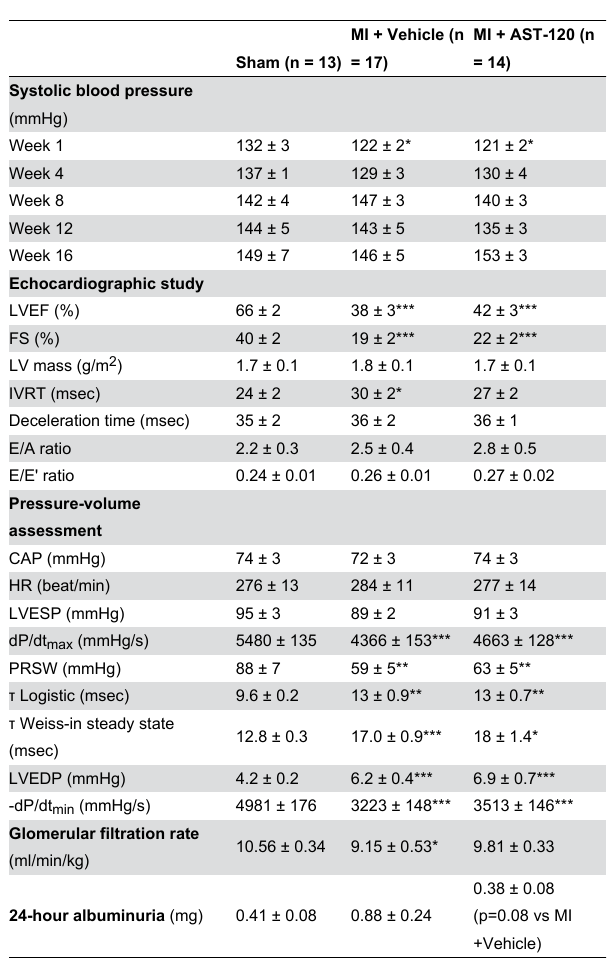
Table 2. Blood pressure, cardiac function and renal function assessment.